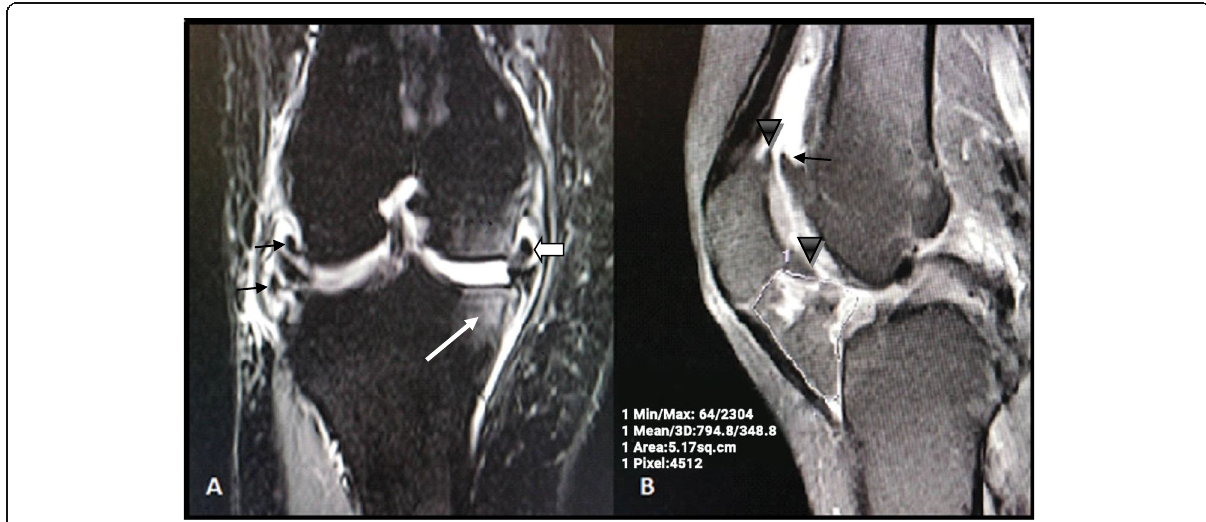
Fig. 4 Advanced osteoarthritis on MRI. a Sagittal STIR image showing advanced osteoarthritic changes with bulky marginal osteophites (short arrows), subchondral BML (long arrow), and intra-articular loose body (bold arrow). b Sagittal T2WI with fat saturation showing patellar polar spurs (black arrowheads), corresponding IPFP area = 5.17 cm